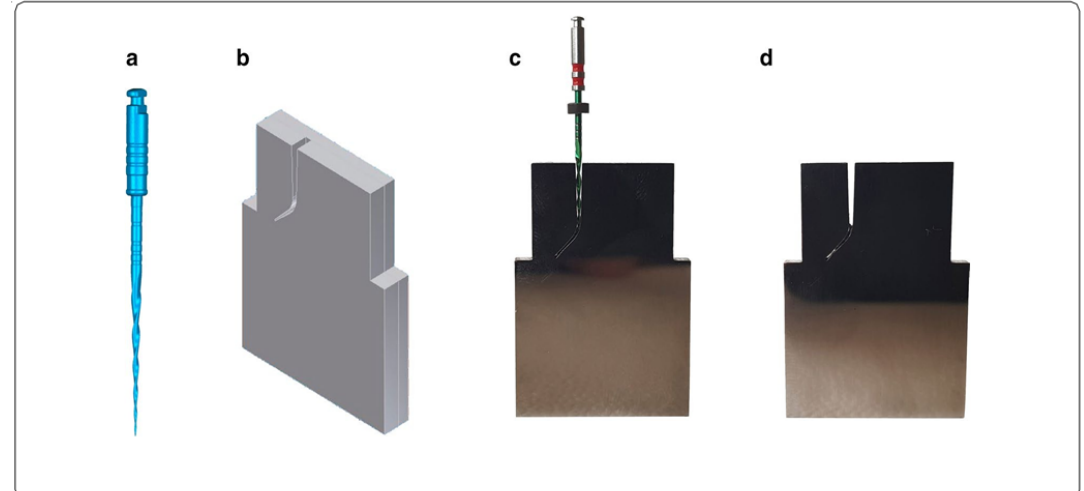
Figure 2. Design of artificial root canal. ( a ) Stereolithography (STL) file of the endodontic rotary file; ( b ) STL file of the artificial root canal; ( c ) endodontic rotary file in intimate contact with the artificial root canal and ( d ) artificial root canal manufactured by electrical discharge machining (EDM).